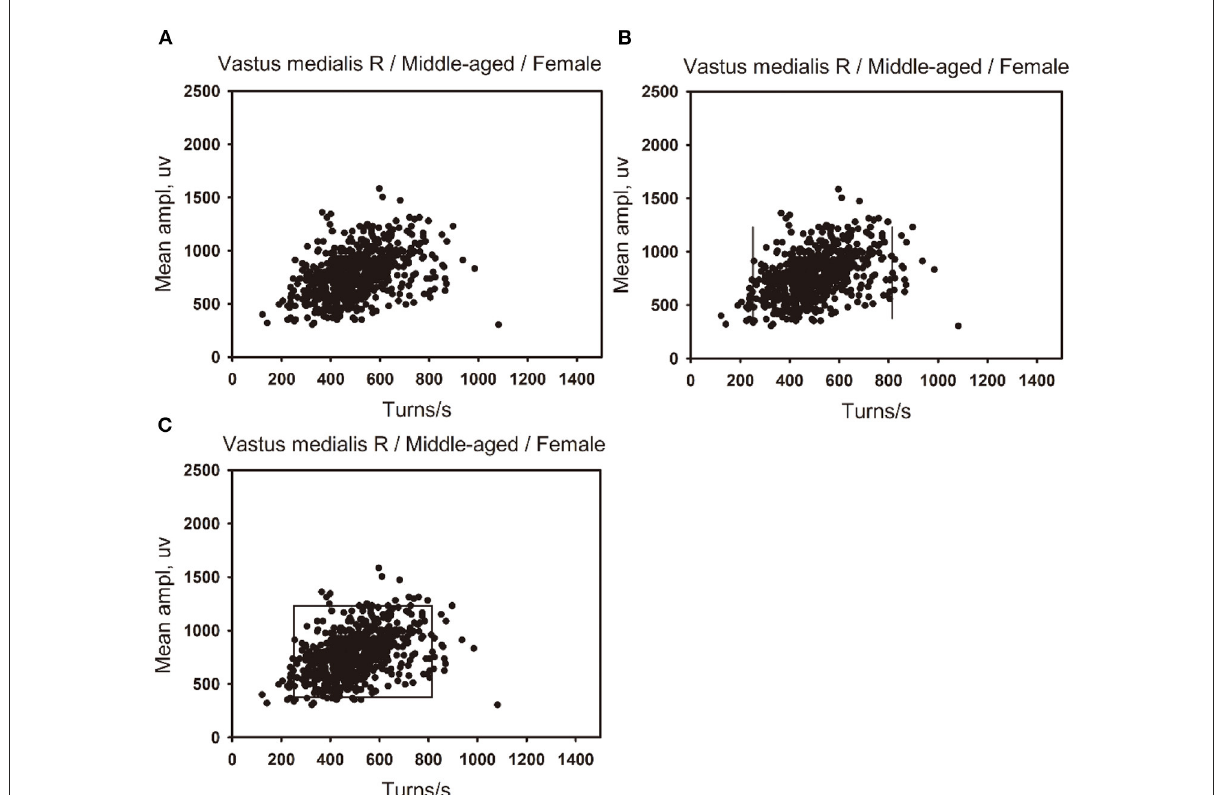
FIGURE2 Developing method of the percentile clouds. (A) A scatter plot was made of the number of turns per second and the mean amplitude of 650 data points of the right vastus medialis in the middle-aged female group. (B) The 2.5 percentile of the number of turns per second is used as the left boundary of the clouds, and the 97.5 percentile is used as the right boundary of the clouds. (C) The 97.5 percentile of the mean amplitude is used as the upper boundary of the clouds, and the 2.5 percentile is used as the lower boundary of the clouds.